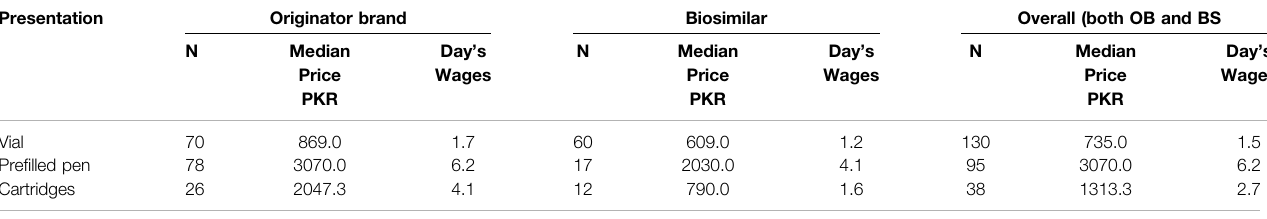
TABLE 6 | Median prices and affordability of insulin presentation (10 ml 100IU/ml) in the private sector. Presentation